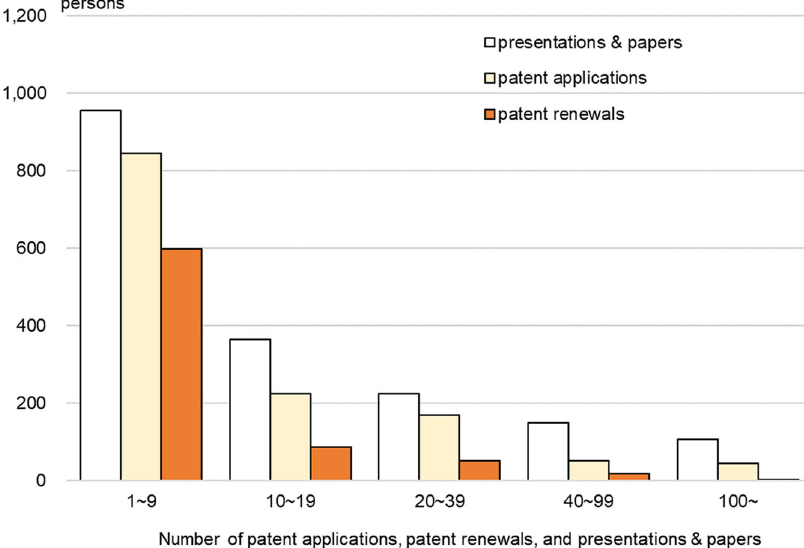
Fig. 3 Distribution of respondents for R&D output-related indices. Number of patent applications and renewals represents the total number of patent applications and renewals made throughout the respondent ’ s career in R&D. Number of presentations & papers represents the total number of presentations that a respondent has given at academic conferences and papers published in academic